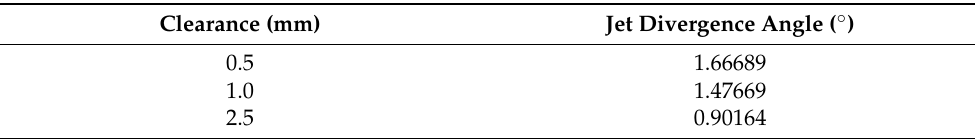
Figure 9. ( a–c ) The effect of changing the clearance ( C ) on the streamlines of the labyrinth seal under a pressure ratio of 2. Table 3. Jet divergence angles for several